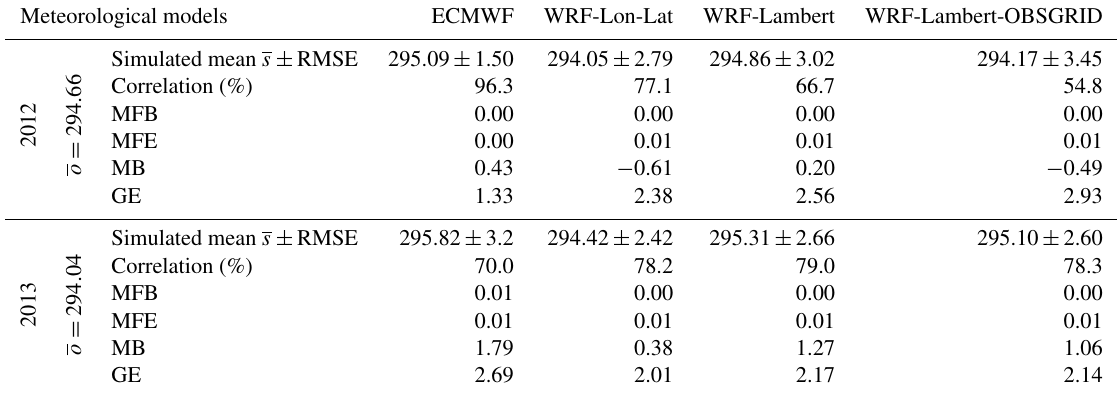
Table 3. Temperature (observed and simulated means) from the observations and the four meteorological models at Ersa during the 2012 and 2013 summer campaigns, and statistics of comparison of model results to observations (correlation, mean fractional bias, mean fractional error, mean bias and gross error). The temperature means and RMSEs are in Kelvin. o refers to the measured mean.